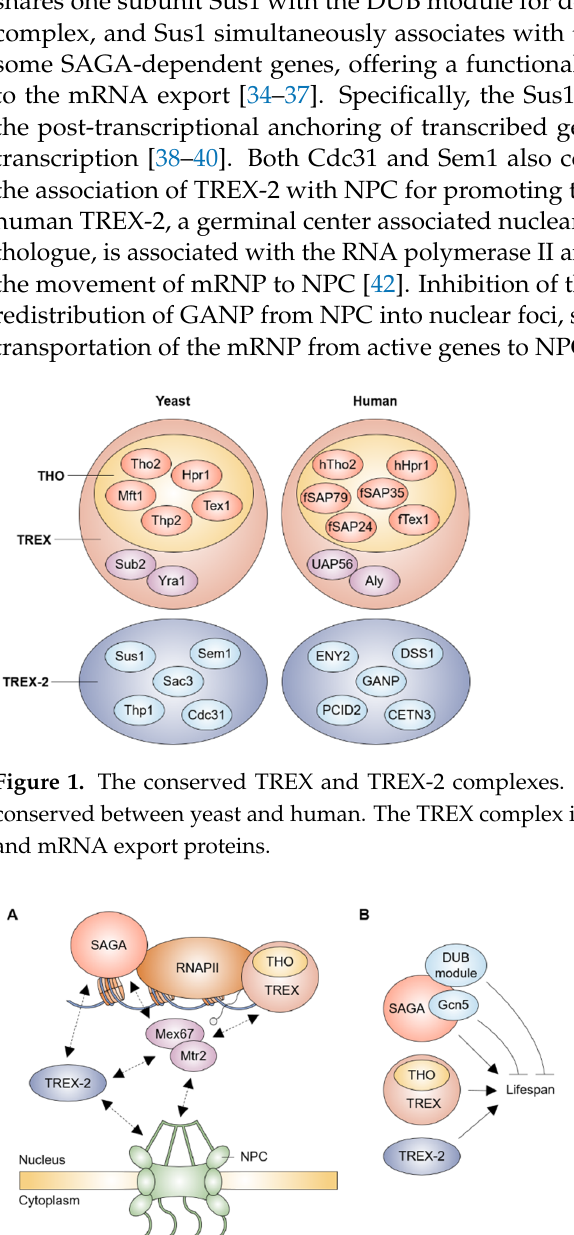
Figure 2. The effects of SAGA, TREX, and TREX-2 complexes on the yeast lifespan. ( A ) Model of SAGA, TREX, and TREX-2 complexes-mediated mRNA export pathway. At the stage of transcription initiation, SAGA is recruited to RNA polymerase II (RNAPII) machinery and mediates activation of transcription. TREX is co-transcriptionally recruited and associates with nascent transcripts. The mRNA export receptor Mex67-Mtr2 interacts with SAGA, TREX, and TREX-2 complexes and NPC, which facilitates passage of mature mRNP to cytoplasm. TREX-2 shares a component with SAGA and promotes anchoring of mRNP to NPC. Illustration reflects the relevant location of proteins but not precise physical association. ( B ) Many subunits in SAGA, TREX, and TREX-2 are required for blocking a shortened lifespan, whereas Gcn5 and DUB module (except for Sus1) in SAGA limit an abnormal extension of the